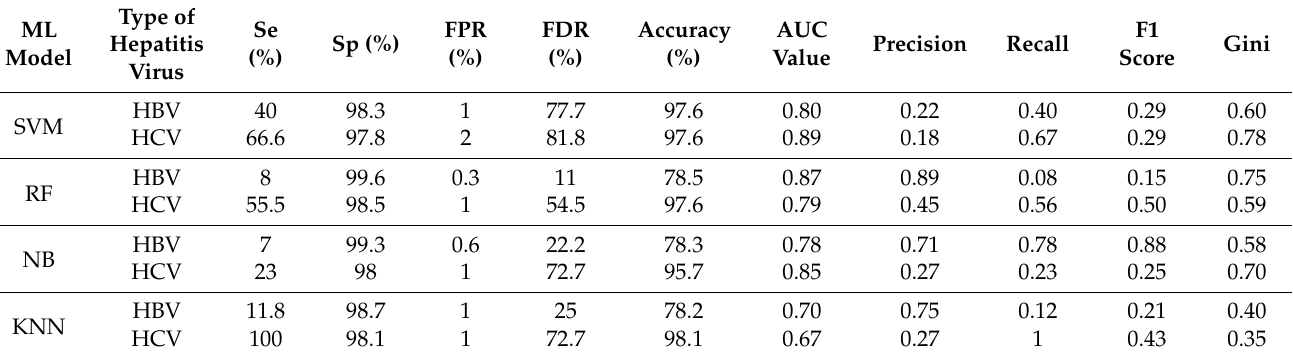
(Table 3). KNN achieved the highest accuracy when predicting HCV status (98.1%), with an AUC value of 0.67. The SVM had equal accuracies (97.6%) for the prediction of both HBV and HCV status, but the AUC value was higher for HCV classification (0.89 versus 0.80). Both RF and NB performed best when used to predict the HCV status (RF: accuracy—97.6%; AUC—0.79; NB: accuracy—95.7%; AUC—0.85). In terms of sensitivity, it was higher for algorithms that predicted HCV status, with KNN having the highest sensitivity (100%). Table 3. The predictive performance of machine learning-based models for HVB and HVC prediction.